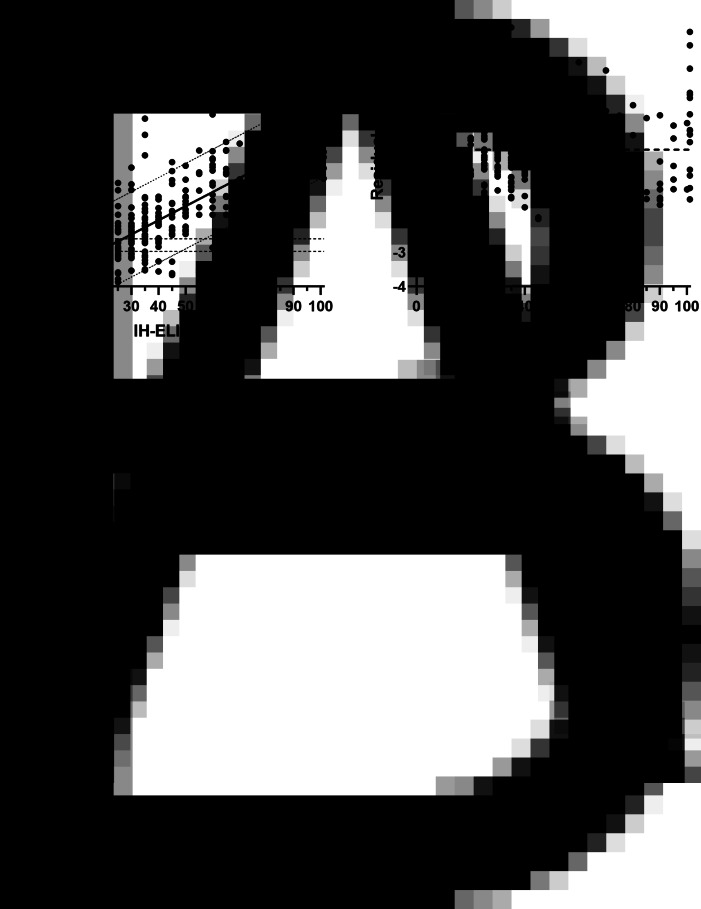
Correlation of the Toxocara reactivity of 541 human serum samples analysed in the Proto-ELISA and the IH-ELISA. (A) RUs of the Proto-ELISA were plotted against antibody units (AU) of the IH-ELISA with subsequent calculation of R2 as indicated by the line of best fit (thick line) and 95% prediction lines (dotted lines). Horizontal dashed lines indicate cut-off values for borderline (⩾0.8 to >1.1) and positive (⩾1.1) results of the Proto-ELISA. (B) Residuals of the regression line plotted against the AU of the IH-ELISA. Equal distribution of the residuals around the regression line (dashed line) indicates accuracy of the applied regression model.